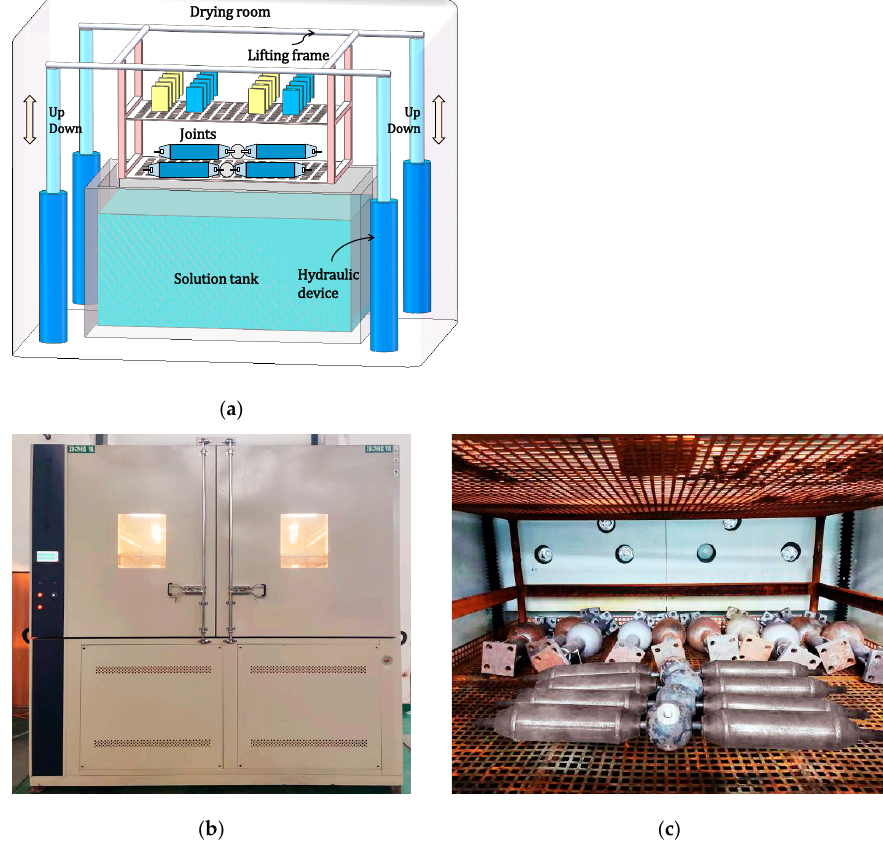
Figure 4. Accelerated corrosion tests: ( a ) schematic diagram of ZY-TL-C1 corrosion device; ( b ) accelerated corrosion device; ( c ) the joints placed on the lifting frame.